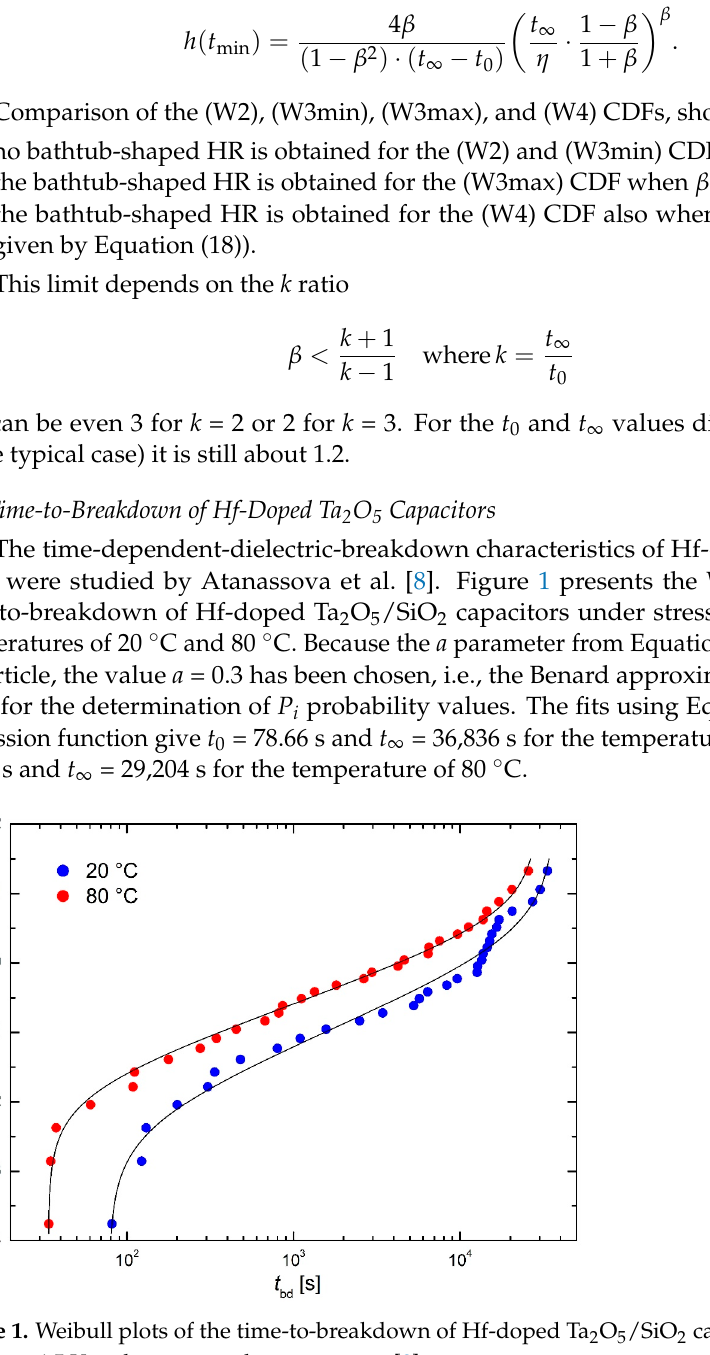
O /SiO capacitors under stress 2 5 2